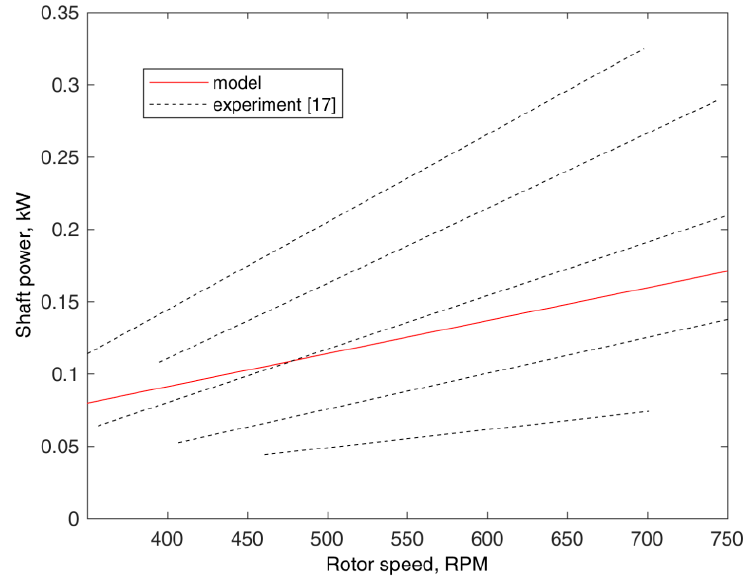
Figure 10. Calculated power of the expander vs. rotor speed compared to experimental data reported in [17].